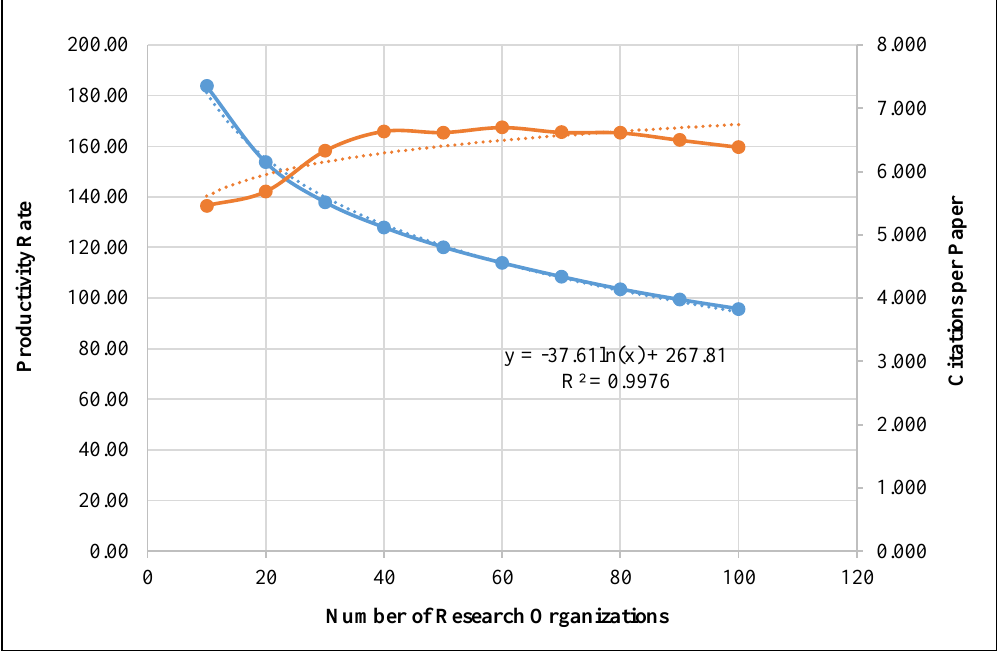
Figure 4. Top 100 Organizations Big Data Research: Quantity vs Quality Performance.